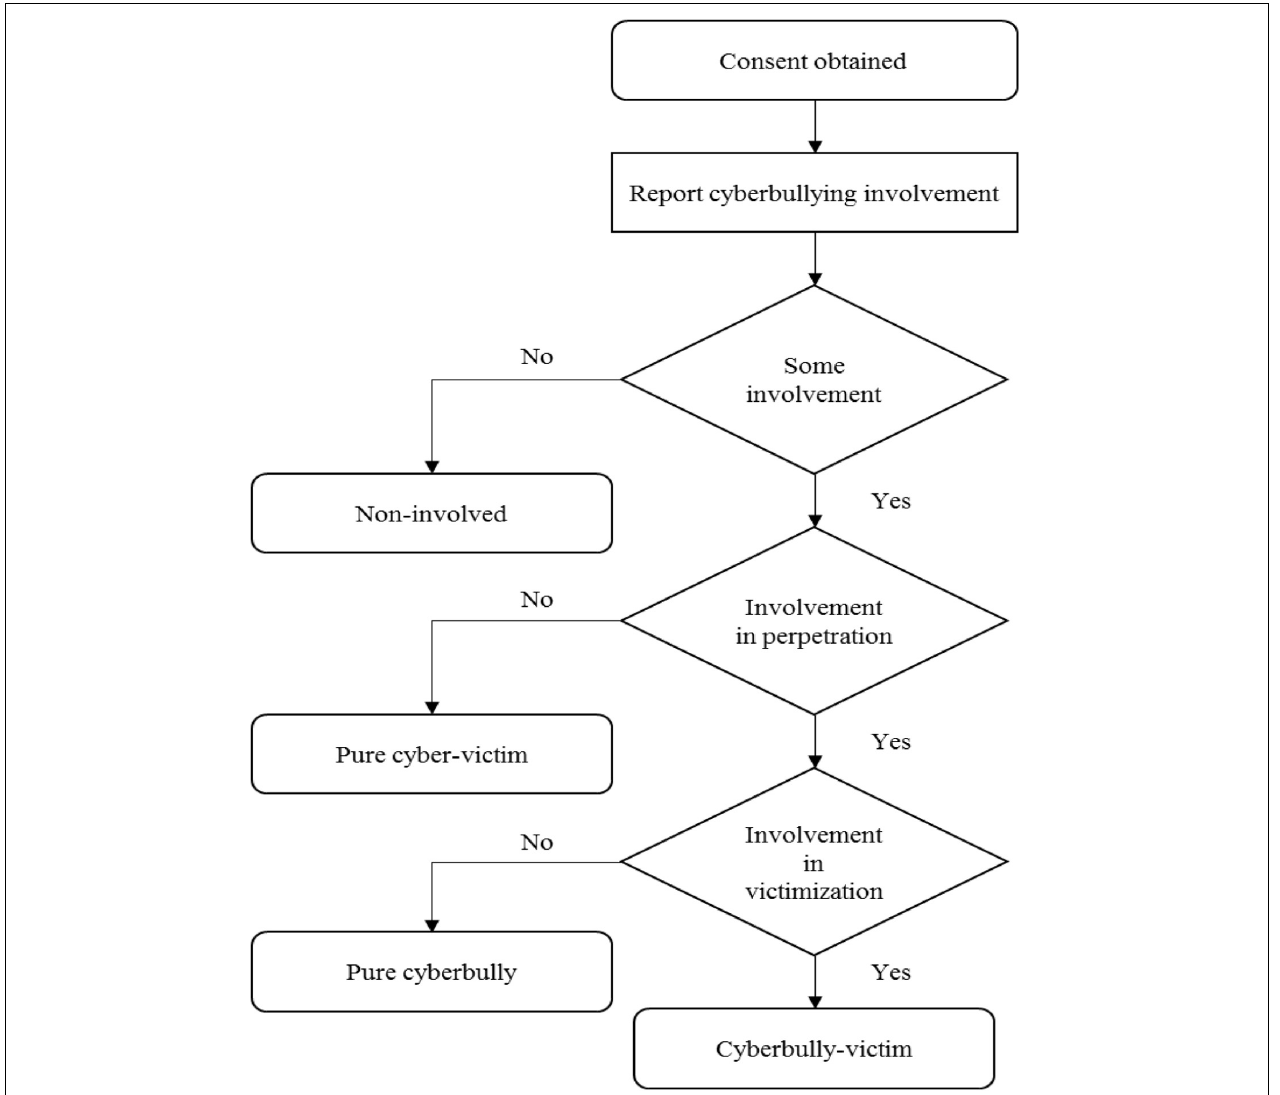
FIGURE 1 | Cyberbully-victim group classification